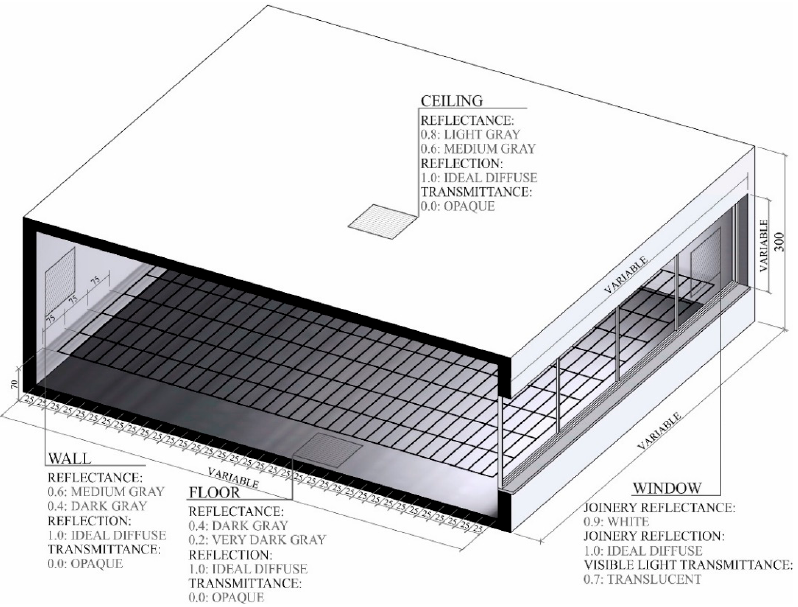
Figure 1. Calculation model.